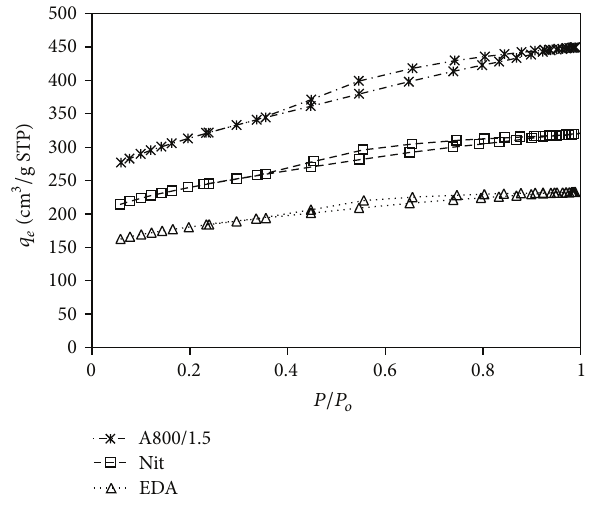
Figure 2: 77 KN 2 -adsorption/desorption isotherms of parent AC (A800/1.5) and modified AC samples (Nit-AC and EDA-AC).